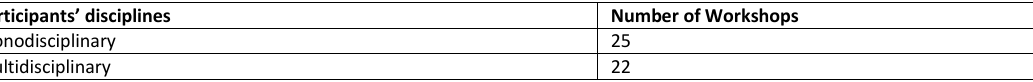
Table 9 The number of workshops across workshop participants’ disciplines